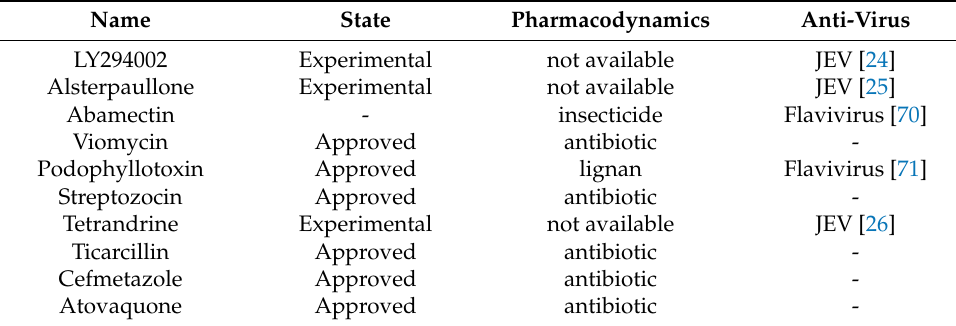
Table 3. The agent information of the anti-JEV